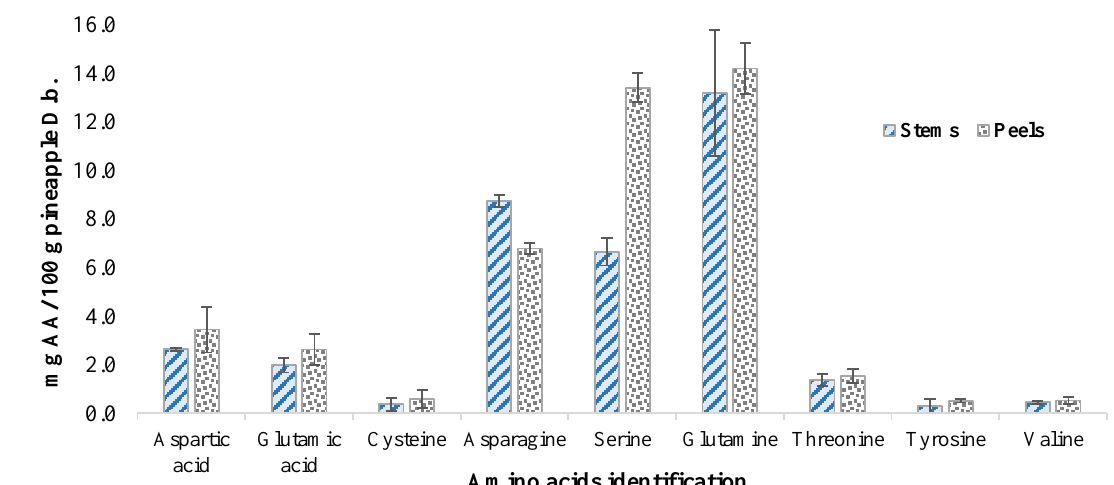
Figure 2. Identification and quantification of free amino acids of pineapple by-products (stems and peels). Abbreviations: D.b — Dry basis; AA — Amino Acids.